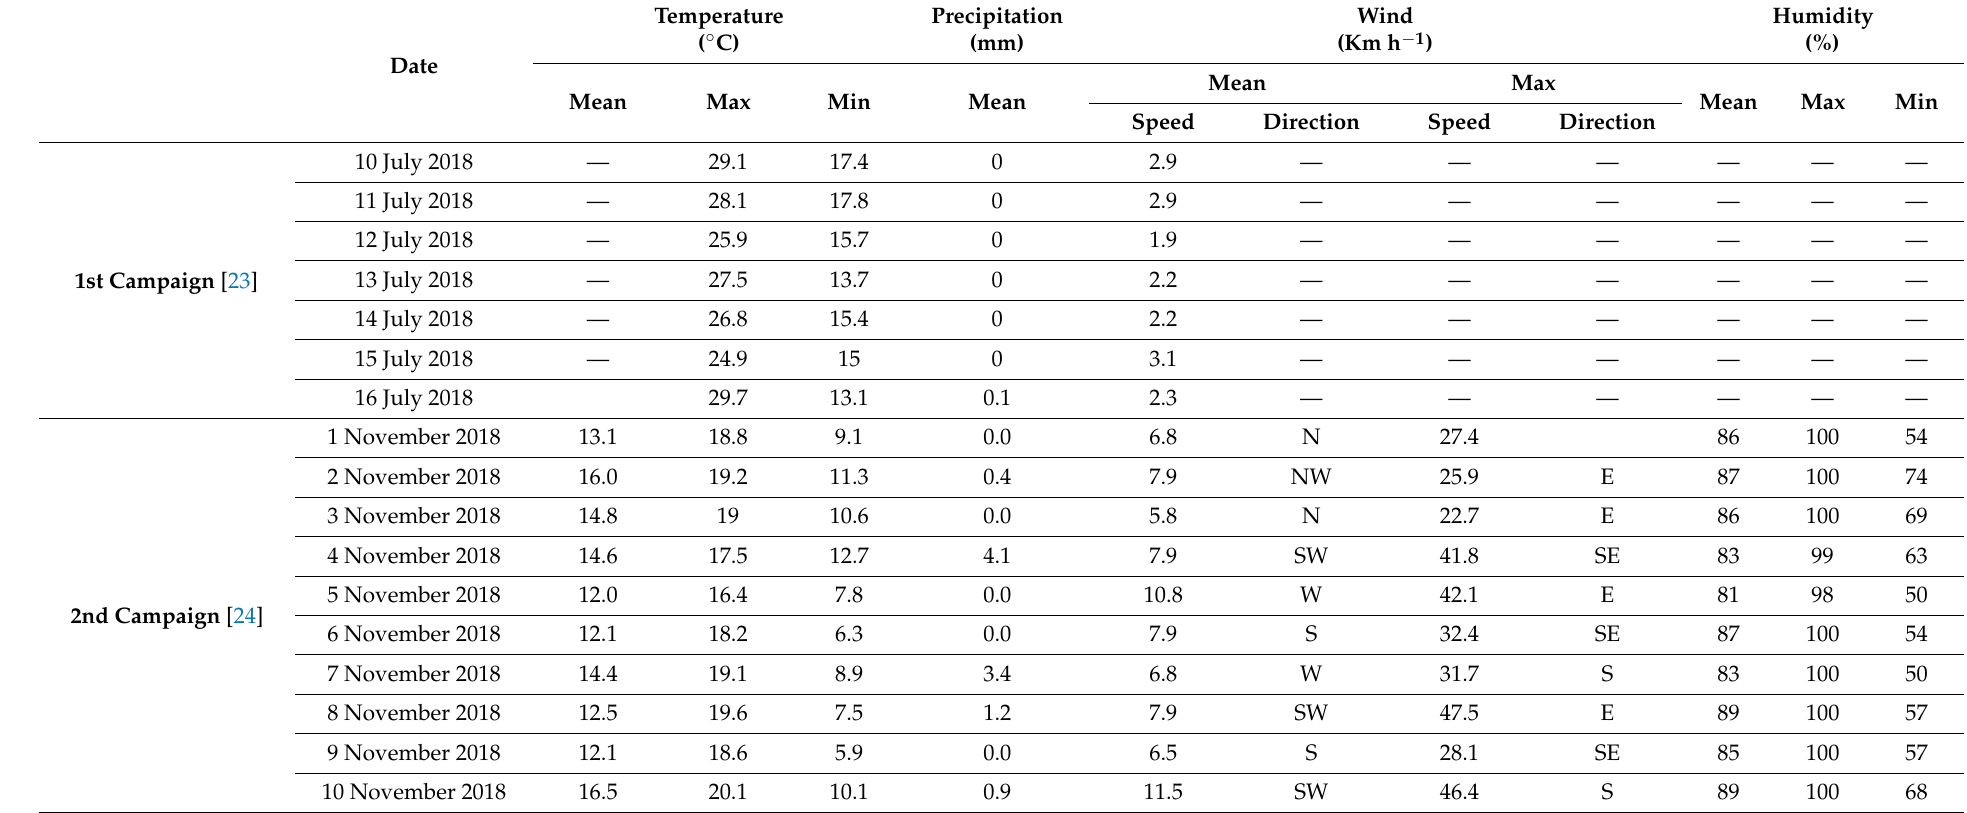
Table 1. Meteorological data collected during the two campaigns carried out in